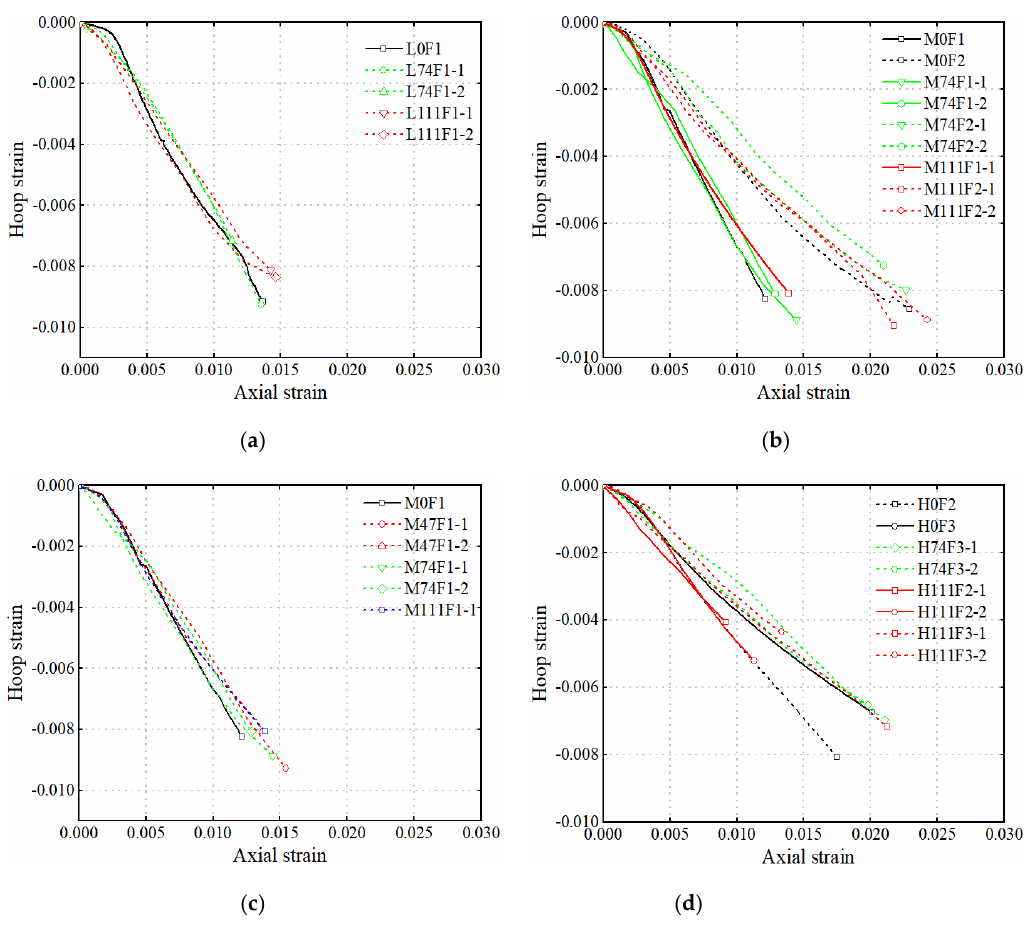
Figure 9. Axial load–axial strain curves of all test specimens: ( a ) series L; ( b ) series M with different confinement strengths; ( c ) series M with different relative diameter ratios; ( d ) series H.